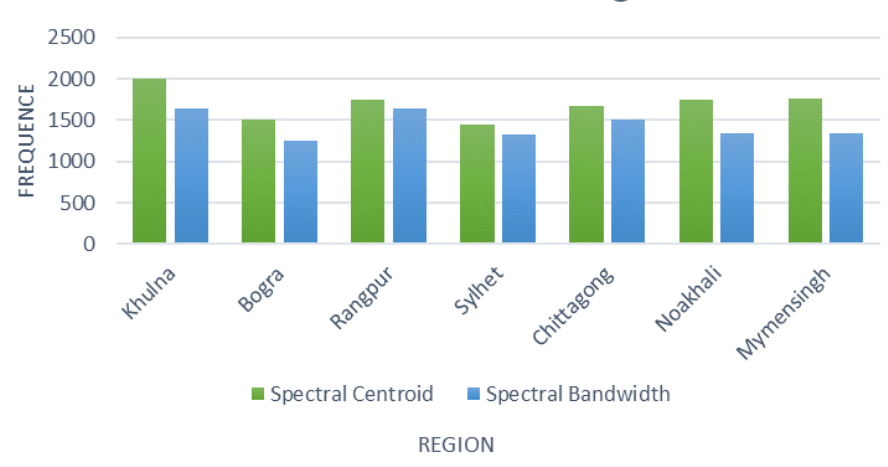
Figure 3. Distribution of audio features; amplitude envelope, zero-crossing rate, and root mean square error across the seven regional languages studied in this research.